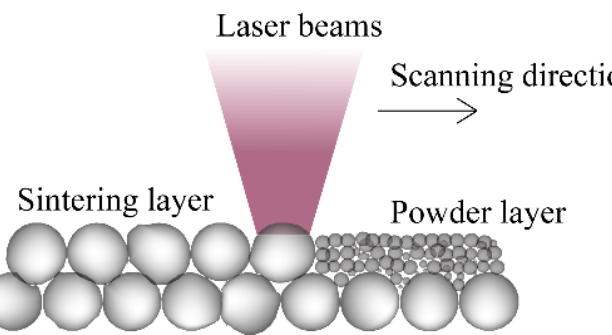
Figure 9. Schematic diagram of laser sintering.The powder composition of SLS is a mixture of high and low melting point powder, mainly nylon, polyamide, and other polymers. For metal SLS, it can be further divided into indirect metal laser sintering and direct metal laser sintering (DMLS) accord- ing to powder composition. The binder material for DMLS is a metal powder with a low melting point, while polymer powder is for indirect metal sintering. Researchers began utilizing DMLS to fabricate aluminum mirrors around 2015 when AM metal mirrors were still in the initial exploration stage. However, DMLS has been gradually replaced by SLM in the field of mirror manufacturing due to the progress of AM technologies.